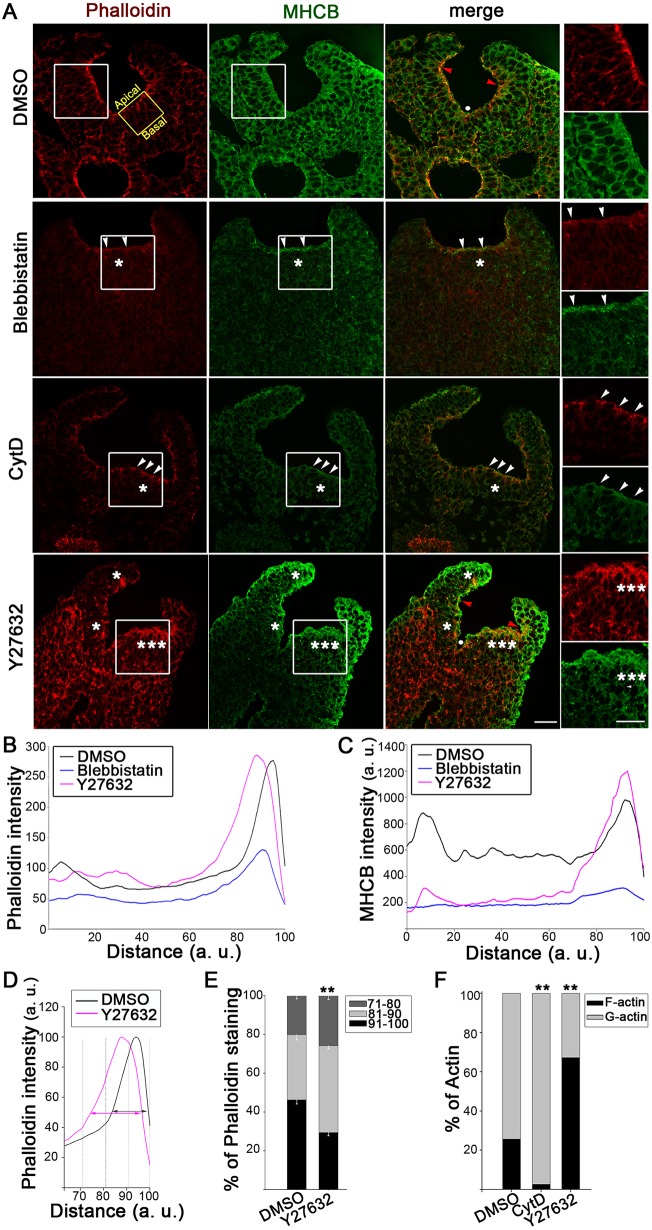
ROCK inhibition leads to actomyosin accumulation in apical neuroepithelium. (A) Immunohistochemistry for F-actin (phalloidin, red) and myosin II (anti-MHCB, green). Culture for 5–6 h in CytD or Blebbistatin strongly reduces apical (arrowheads) and non-apical (single asterisks) staining. In contrast, actomyosin appears abnormally extensive after Y27632 treatment (multiple asterisks). Note the presence of the MHP (white dot) and DLHPs (red arrowheads) in both Y27632-treated and DMSO control embryos. Right, enlargement of the boxed areas. The yellow box in top left image shows the typical area of neuroepithelium in which basal-to-apical staining intensity was measured. Embryos shown have 17–19 somites. Scale bars: 30 µm. (B,C) Intensity profile scans of phalloidin (B) and anti-MHCB (C) staining along the neuroepithelial basal-to-apical axis. Basal surface, 0; apical surface, 100 (a.u., arbitrary units). F-actin is enhanced apico-basally and MHCB is redistributed to the apical surface in Y27632-treated embryos compared with DMSO controls. Blebbistatin reduces both F-actin and MHCB. (D,E) With maximum intensity normalized to 100%, the apical domain of phalloidin staining extends farther basally in Y27632-treated embryos than in DMSO controls (arrows in D). Quantification in the three apical neuroepithelial bins (71–80%, 81–90%, 91–100%) shows that phalloidin extends significantly more basally in Y27632-treated embryos compared with DMSO (**P<0.001 in E). (F) Biochemical fractionation of F- and G-actin. Stable F-actin represents 70% of actin in Y27632-treated embryos, only 25% in DMSO controls and less than 3% after CytD treatment (**P<0.001). Significance values were calculated with a Student's t-test, compared with DMSO control.